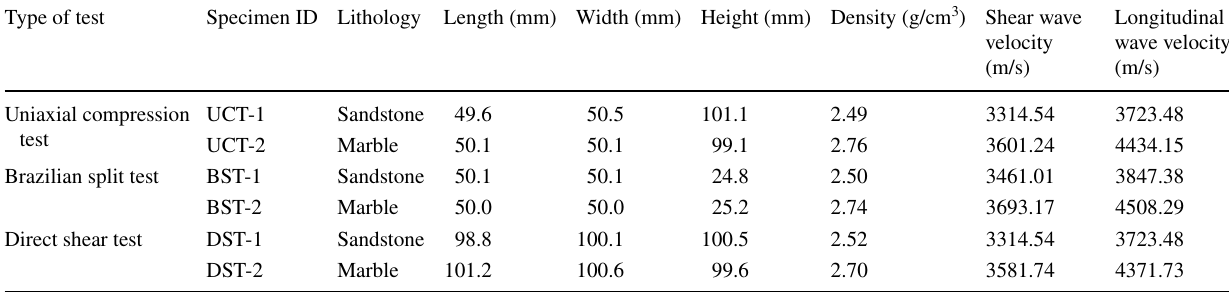
Table 1 Details of tested samples Type of